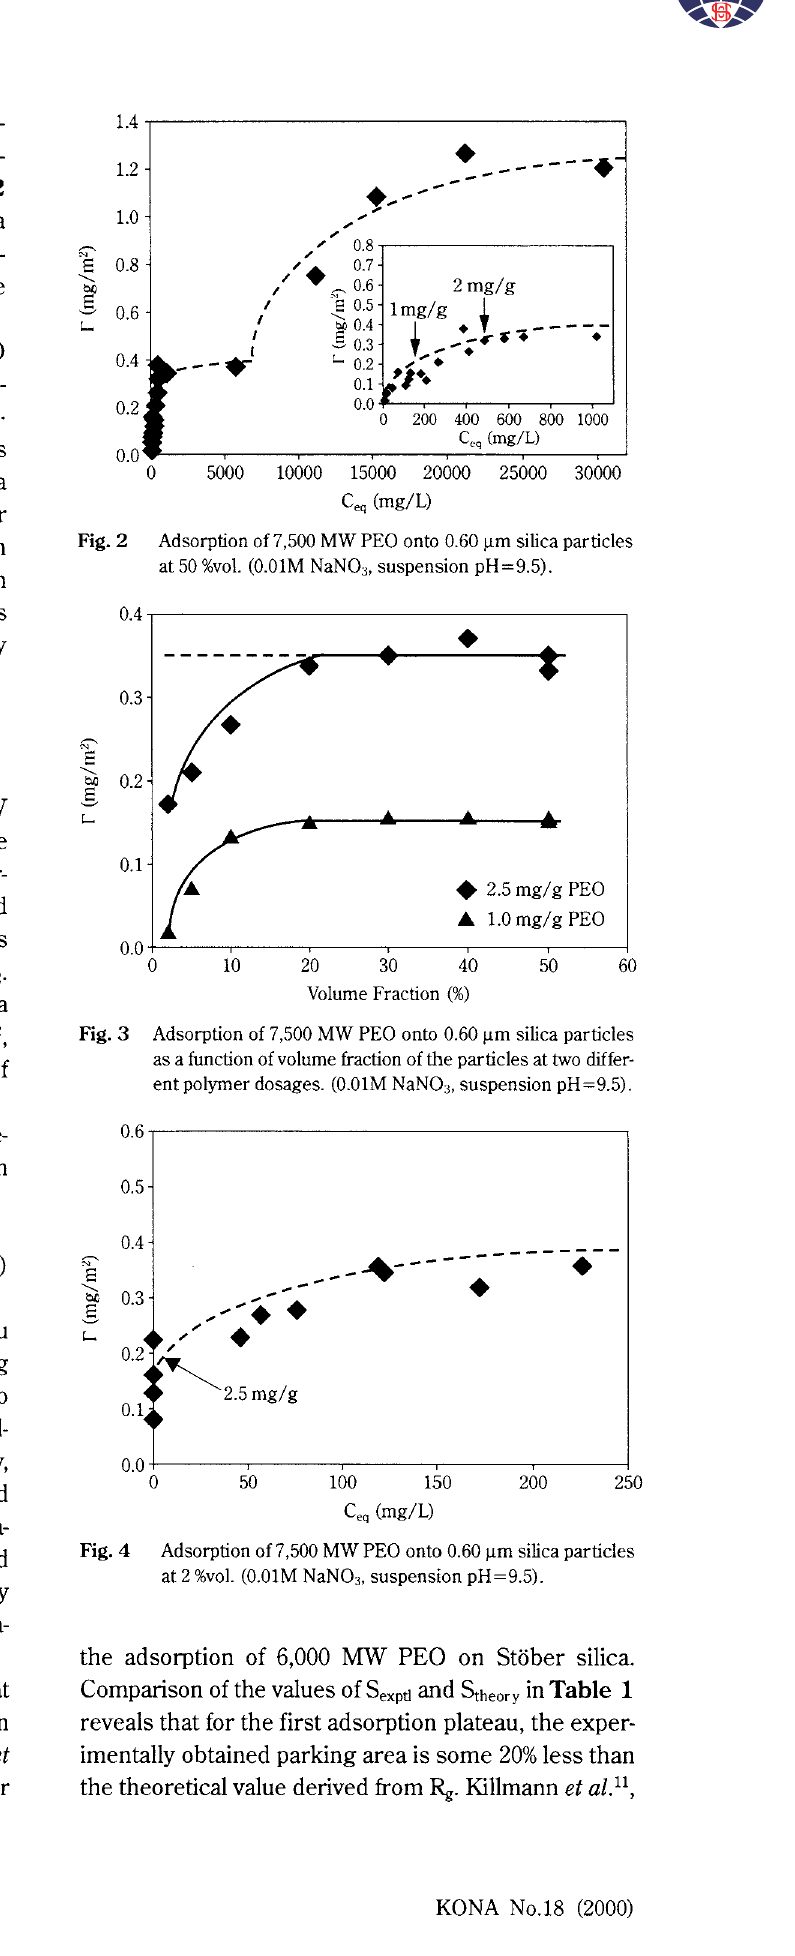
the adsorption of 6,000 MW PEO on StOber silica. Comparison of the values of Sexptl and Stheory in Table 1 reveals that for the first adsorption plateau, the exper imentally obtained parking area is some 20% less